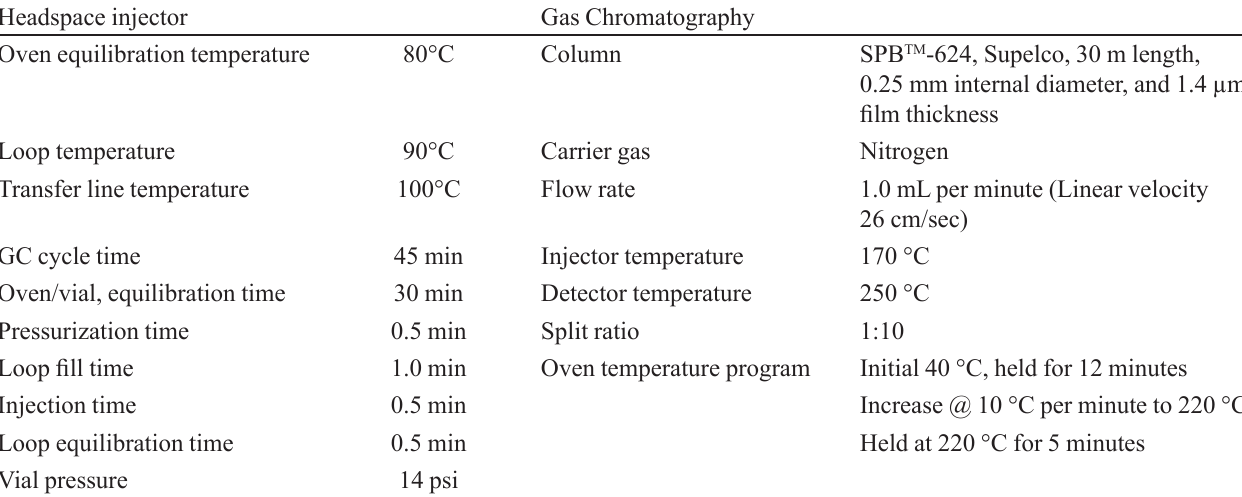
TABLE I - Headspace injector and GC conditions Headspace injector